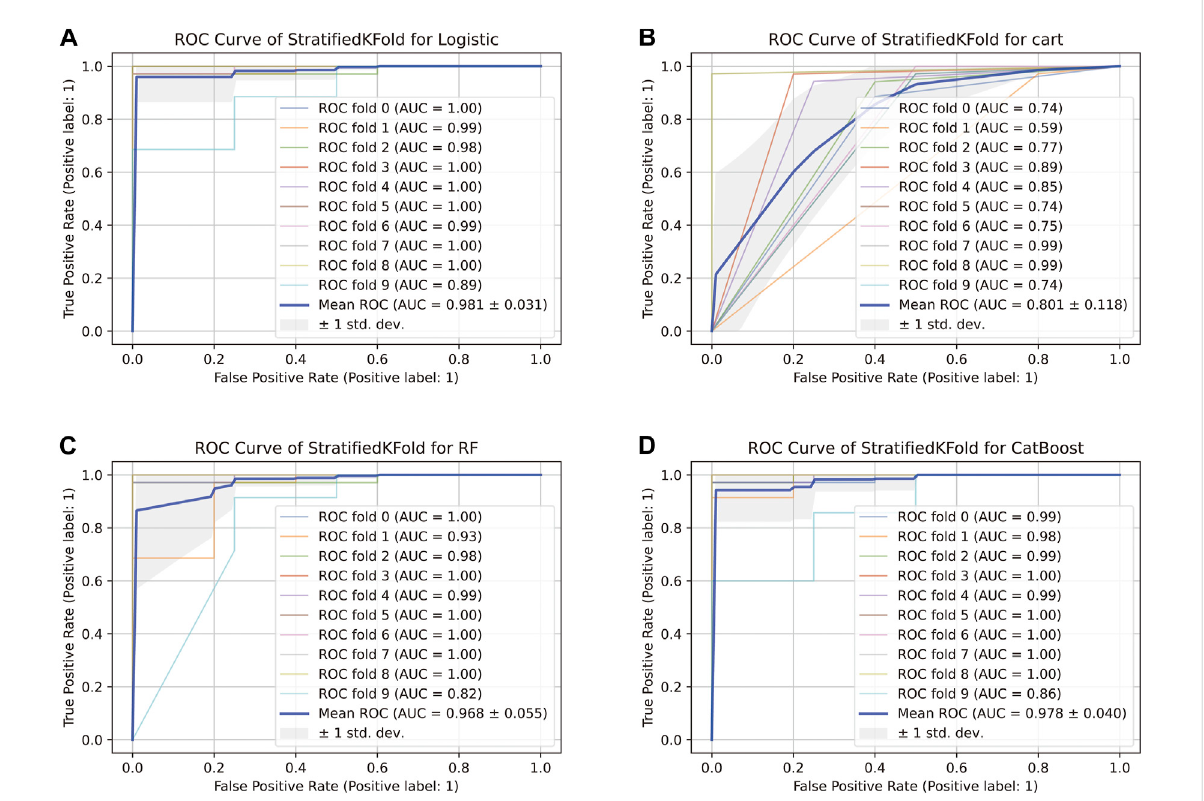
FIGURE 4 ROCcurveofthestrati fi edK-Foldanalysis. (A) ComparisonofROCcurvesofthelogisticmodelbasedonthetenfoldcross-validationresults. (B) Comparison ofROC curves oftheDecisionTree model based on thetenfoldcross-validation results. (C) Comparison ofROC curvesoftheRandom Forest model based on the tenfold cross-validation results. (D) Comparison of ROC curves of the CatBoost model based on the tenfold cross- validation